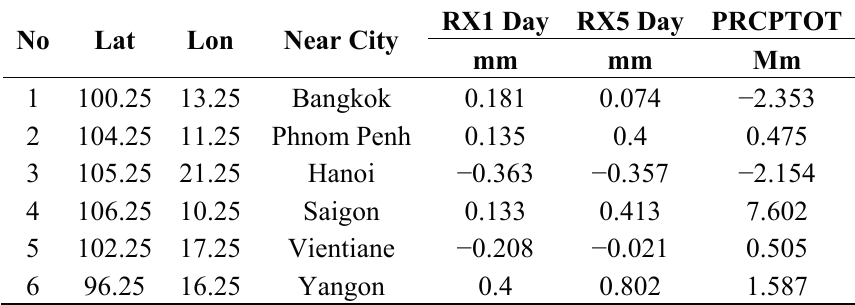
Table 5. The trends of intensity indices close to major cities in Indochina.